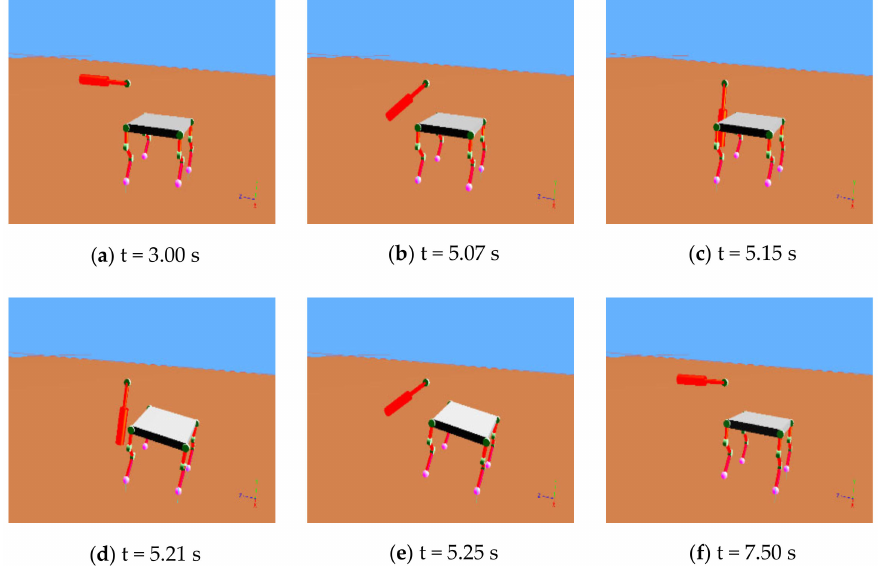
Figure 12. Simulation process of quadruped robot subjected to lateral impact. At the beginning, the robot does step movements.